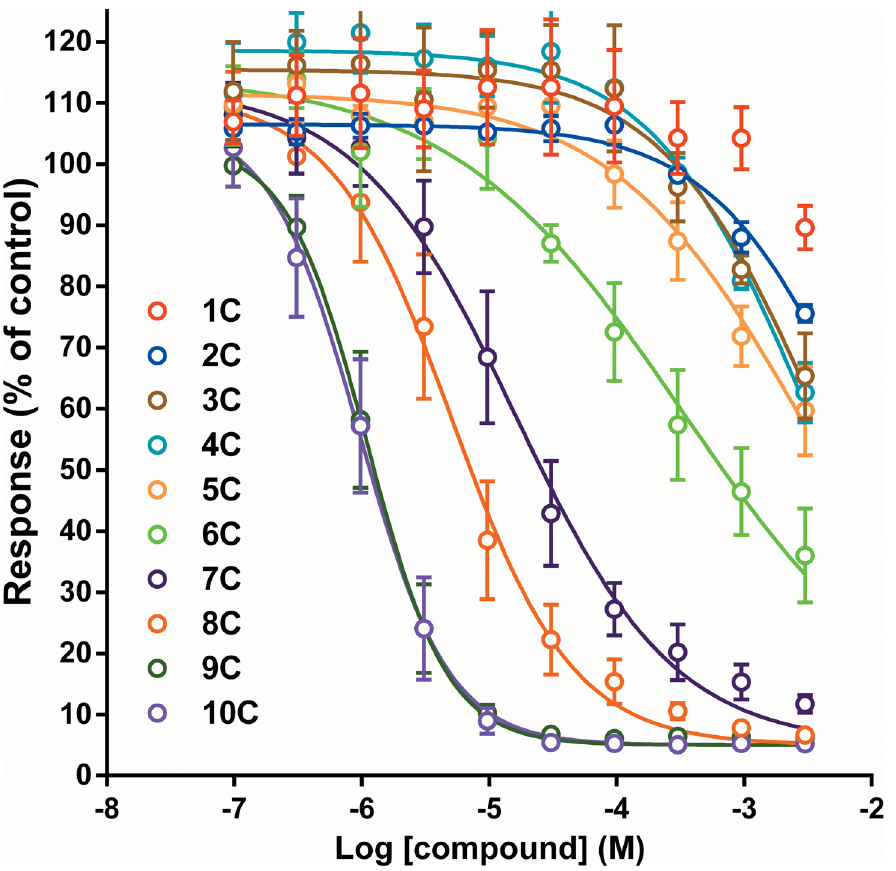
Fig 3. Influence of linker length on the effect of the bispyridinium compounds in CN21 cells. The Ca 2+ response to ACh (10 μ M) was measured in CN21 cells using a FlexStation plate reader in the presence of different concentrations of the test compounds. Data are displayed as the mean ± SEM of three experiments performed in duplicate on each plate. Curves were fitted with a standard four-parameter logistic equation (see text). The fit did not converge for the C1 compound